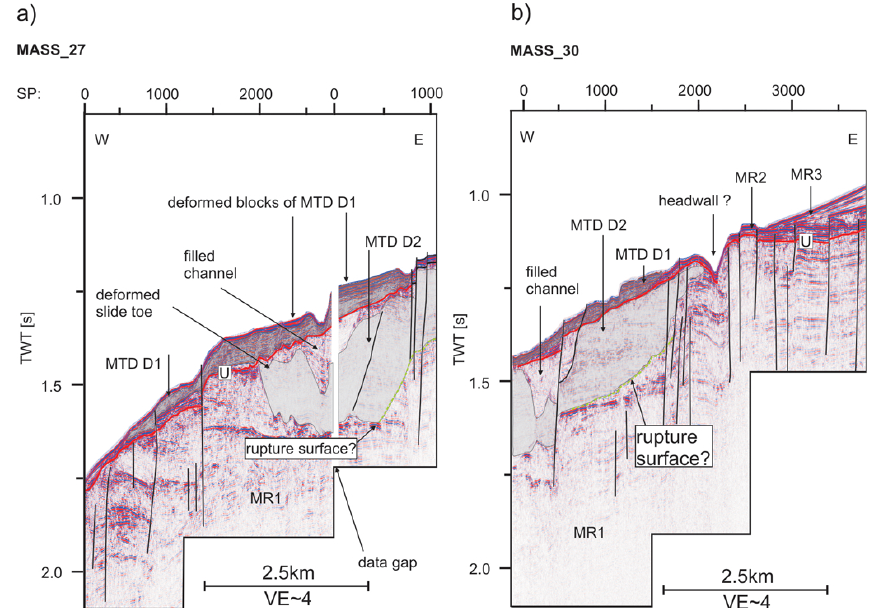
Fig. 9. Seismic profiles showing the edge of Mergui Ridge. The vertical lines indicate positions of faults. The red line marks unconformity U . (a) Deformed toe of MTD D2 (coloured in light grey). (b) Head area of D2 (coloured in light grey) with a steep scarp at its upper part, which may represent the modified head wall (see text for details). The green dotted line indicates the location of a possible rupture surface of D2. See Figs. 2 and 3 for the location of the